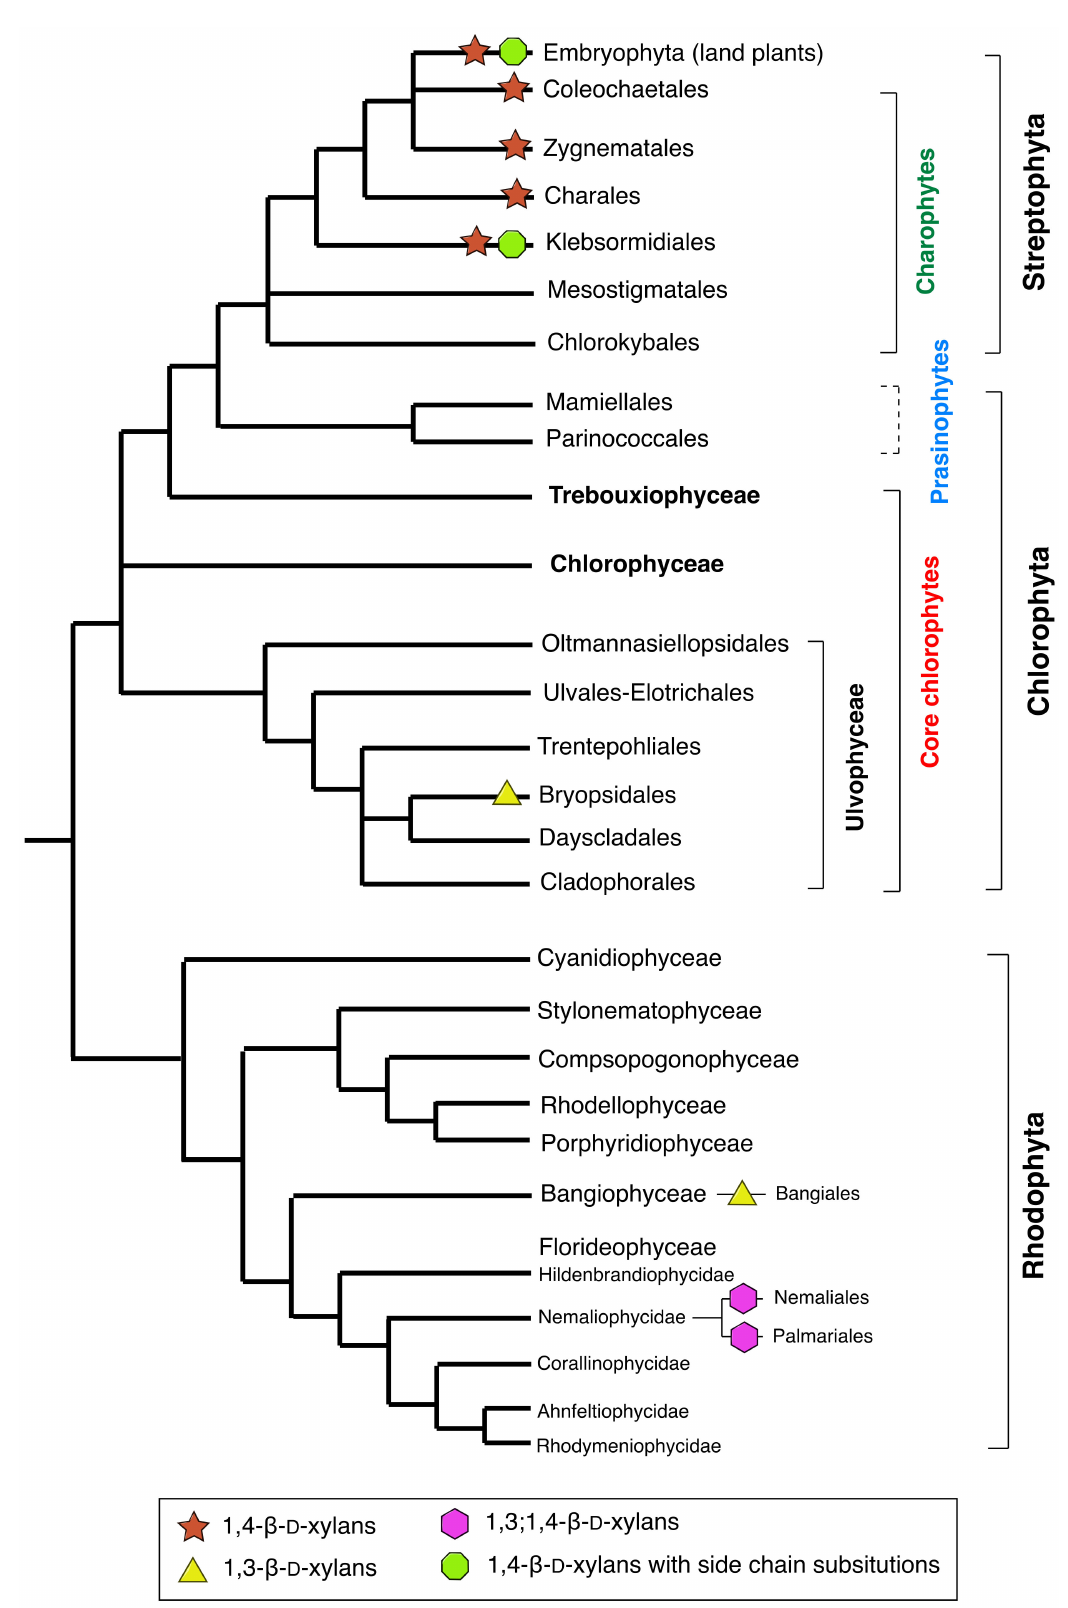
Figure 2. Phylogenies of the red algae [37] and green algae [14] showing the occurrence of xylans. Taxa ending in ‘yta’ are divisions, ‘eae’ are classes, ‘dae’ are subclasses, and ‘les’ are